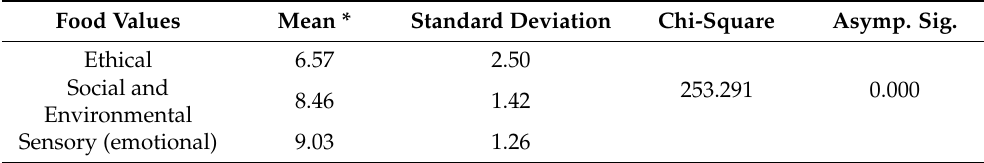
Table 4. Comparison between value dimensions.